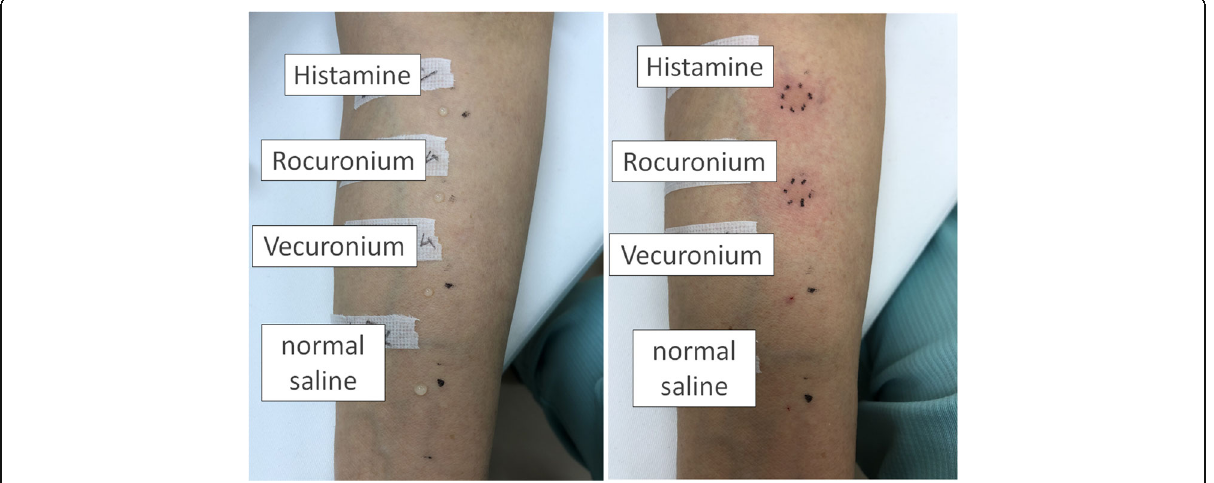
Fig. 1 Skin prick test. From the top, in the order of histamine, rocuronium, vecuronium, and normal saline. The figure on the left is before puncturing, and the figure on the right is 15 min after puncture. Wheals are surrounded by black dots at histamine and